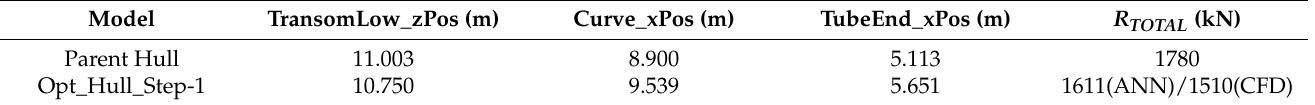
Table 4. Results of the first step of optimization.